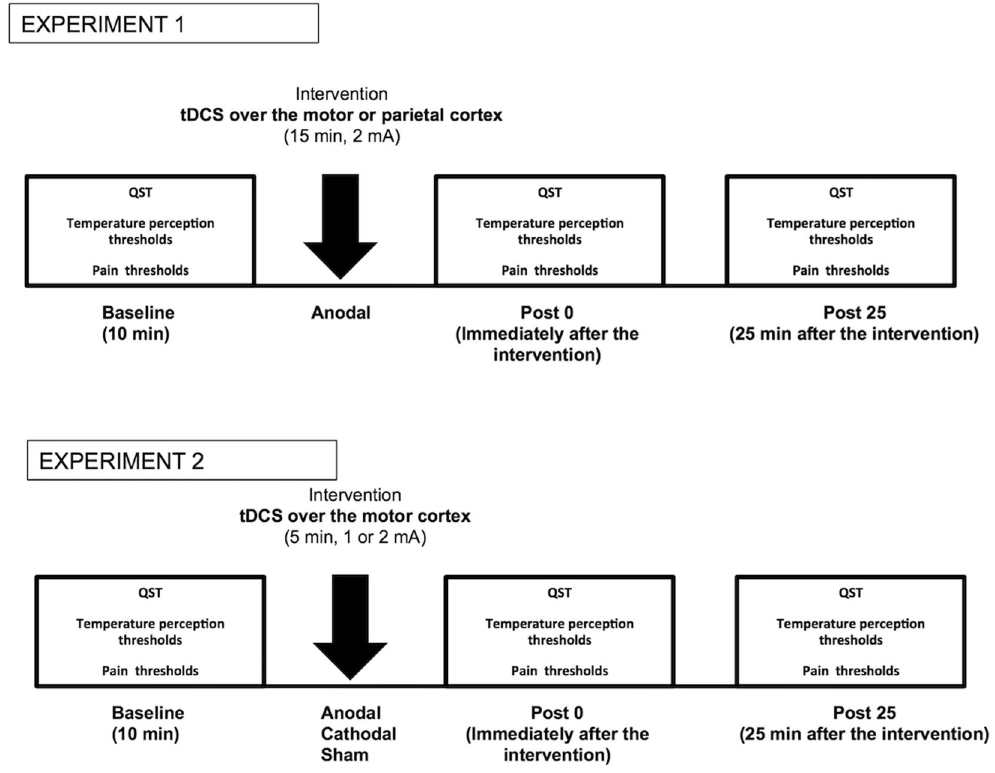
Figure 1. Schematic representation of the experimental